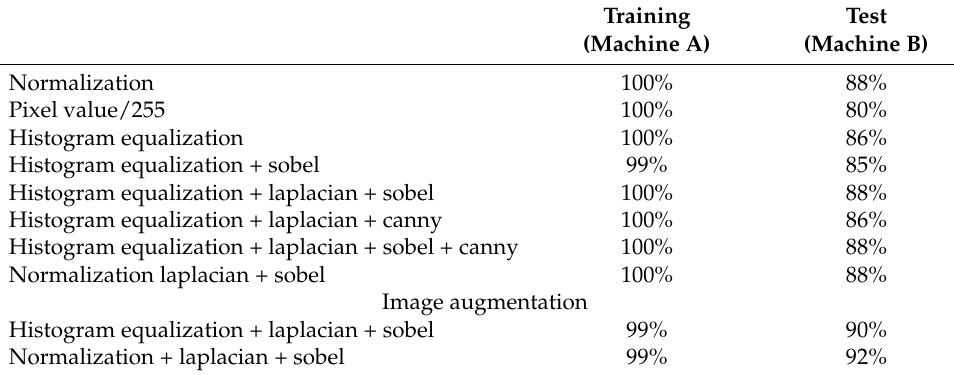
Table 2. The ablation test results of Model 2.